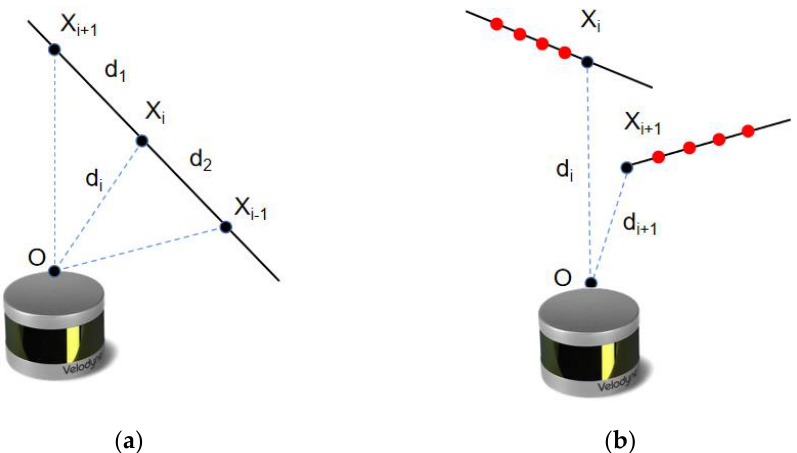
Figure 3. Unstable flaw points. ( a ) Schematic diagram of parallel flaw points; ( b ) Schematic diagram of occluded flaw points.